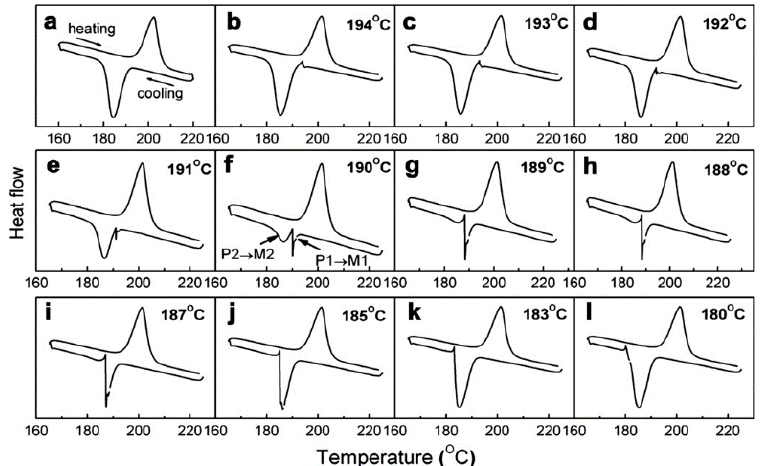
Figure 14. DSC curves of the transformation behavior of the Ni 43 Co 7 Mn 41 Sn 9 alloy measured: ( a ) after a full transformation cycle ( b – l ) and during interrupted cooling [50], with copyright permission from © Elsevier Ltd .